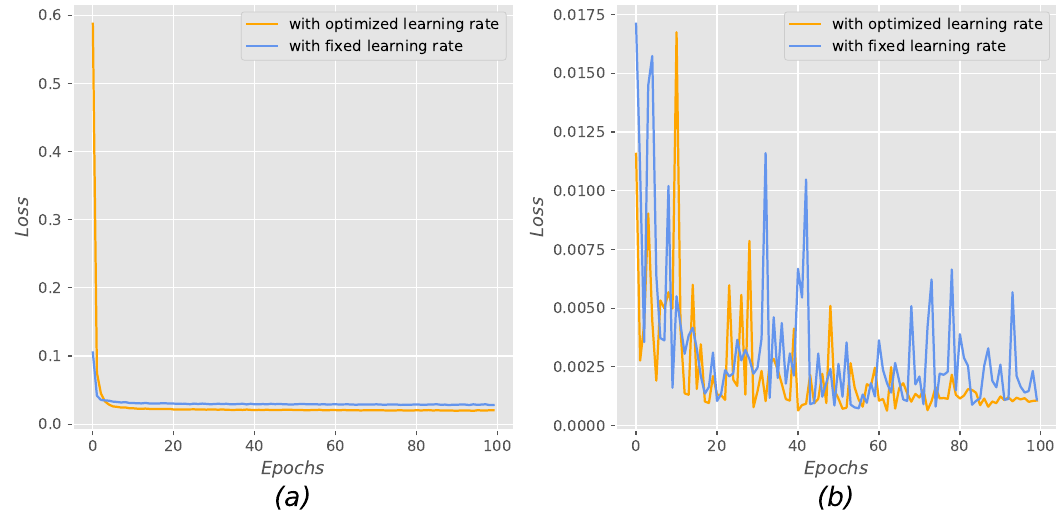
Figure 5. The comparative losses of the model. ( a ) the convergence of the loss function on the training set; ( b ) the convergence of the loss function on the validation